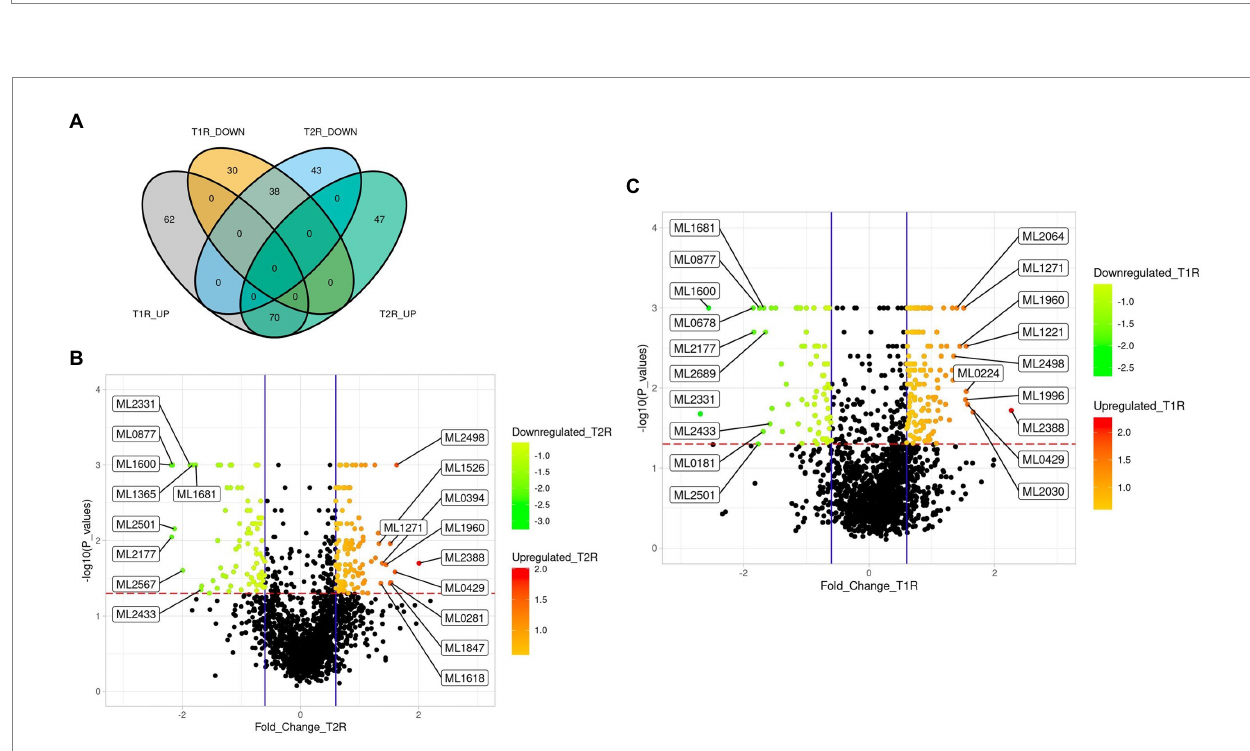
FIGURE 3 (A) Venn diagram representing the number of significantly upregulated and downregulated genes of Mycobacterium leprae across the study groups. (B,C) Volcano plots with log 2 FC (derived from normalized gene expression data) showing the top 10 differentially expressed genes in T1R and T2R compared to NR cases. The overexpressed genes are those with the volcano plot p -values < 0.05 and Log 2 FC values of ≥ 0.6 (mean of each of the reaction groups) and underexpressed genes are those with the volcano plot p -values < 0.05 and Log 2 FC values of ≤ − 0.6 (for the mean of each of the reaction groups). Scales in B and C represent the Log 2 FC